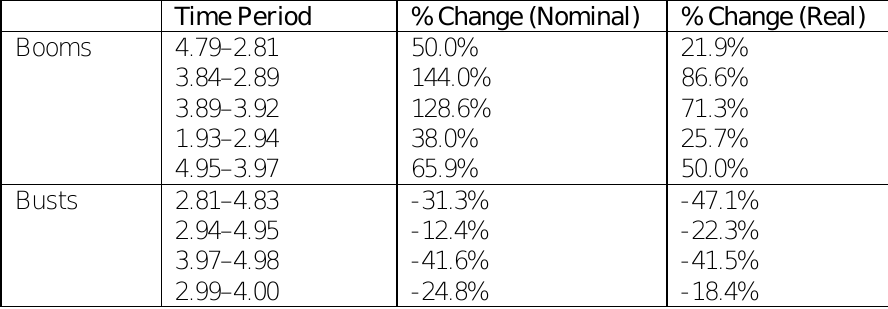
Table 1: Housing Price booms and Busts (Source: Rating and Valuation Department, Hong Kong Government) Time Period % Change (Nominal) % Change (Real)